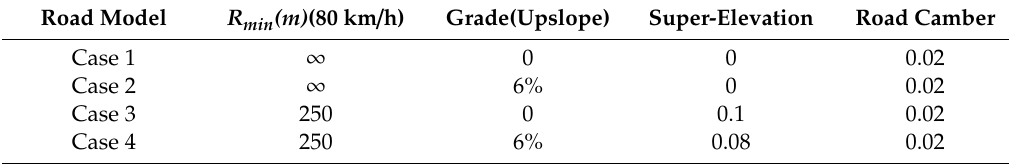
Table 4. Road segments of Single Most Unfavorable Road